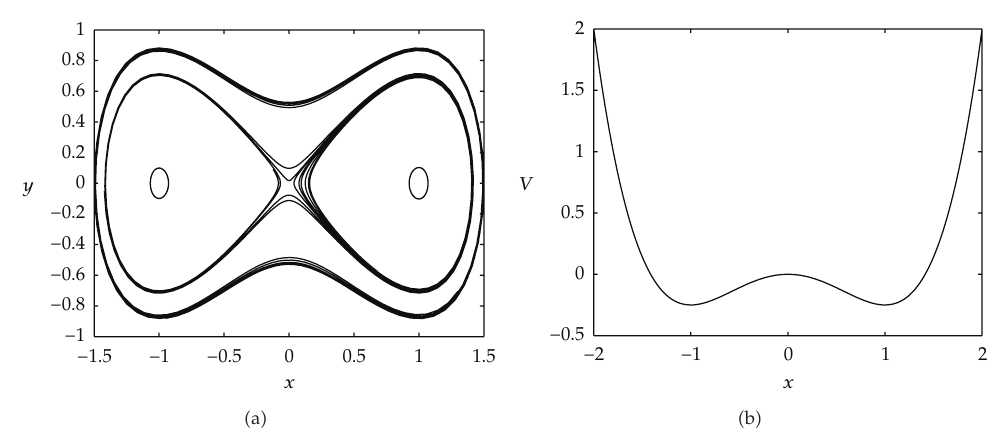
Figure 1: Phase portrait and potential of the system (cid:6) 1.3 (cid:7) and (cid:6) 1.6 (cid:7) as ε (cid:8) 0. System (cid:6) 1.3 (cid:7) : A (cid:8) B (cid:8) 1; System (cid:6) 1.6 (cid:7) : F (cid:8) D (cid:8)